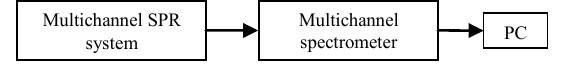
Fig. 1 Multichannel SPR system with an integrated spectrometer.